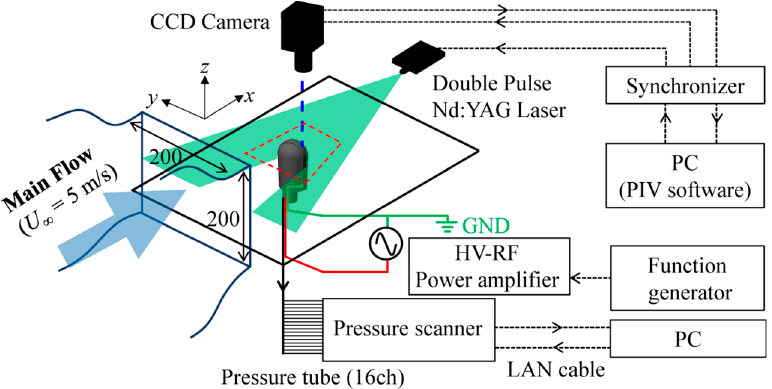
Figure 4. Experimental setup for particle image velocimetry (PIV) and pressure measurement.